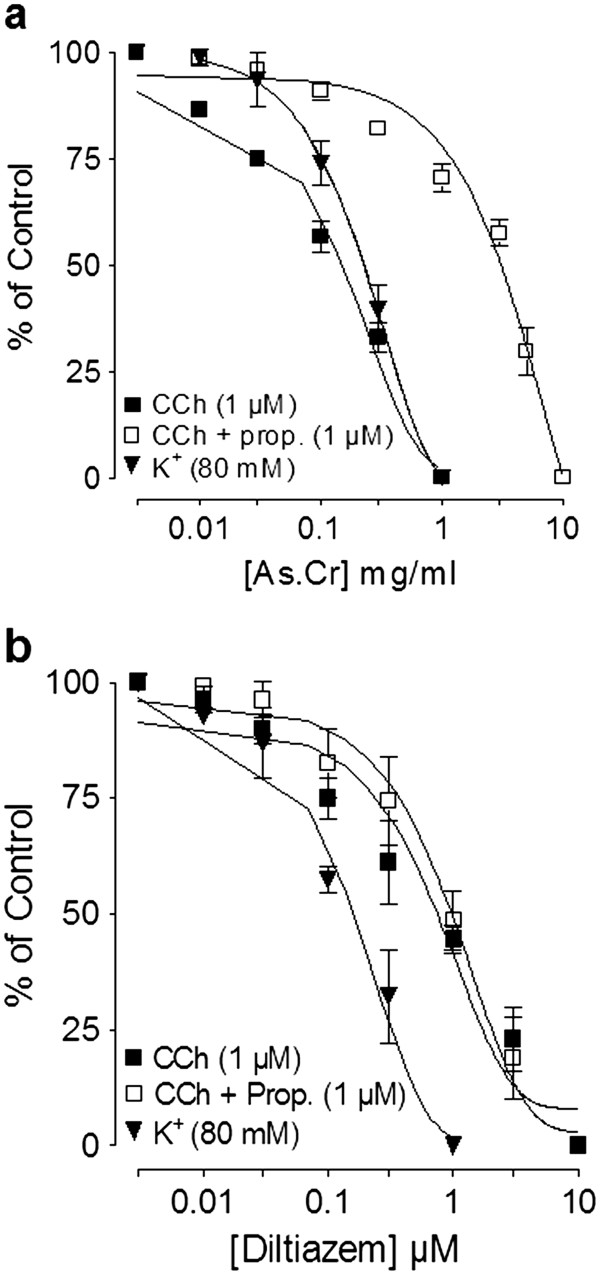
Concentration-dependent relaxation effects of(a) the crude extractofA. spinosus(As.Cr) and (b) diltiazemon K+and CCh-induced contractions inisolated rabbit trachea. Effect of As.Cr on CCh-induced contraction is recorded in the presence and absence of propranolol (prop). Values are shown as mean ± S.E.M., n = 3–6.